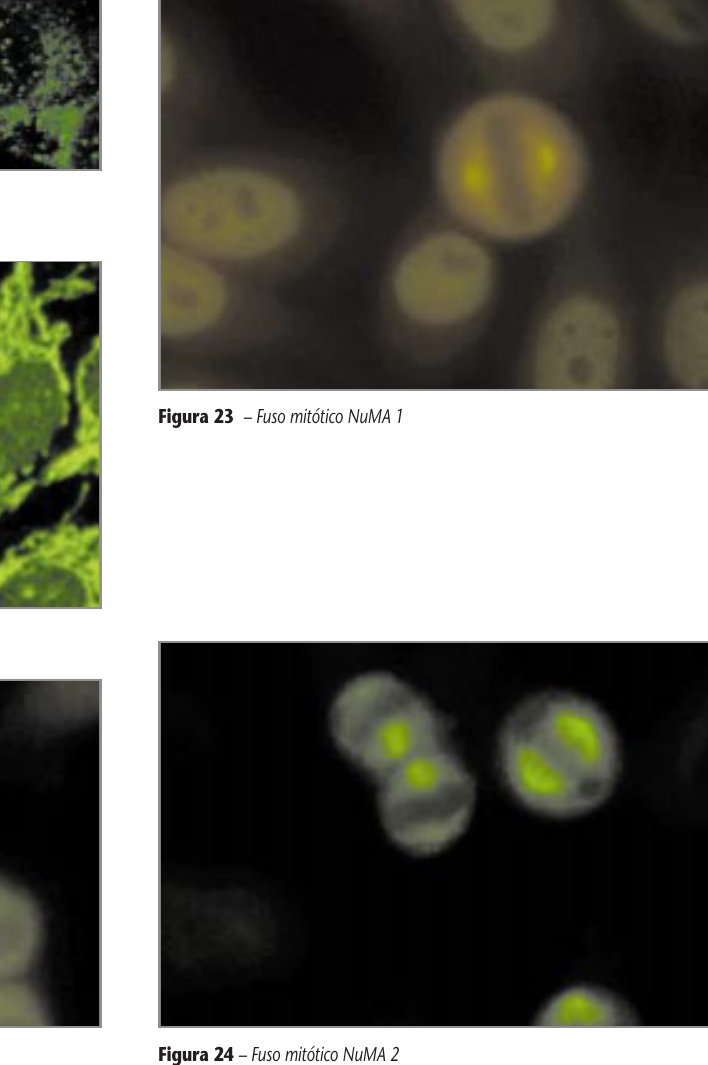
Figura 21 – Aparelho mitótico: centríolo